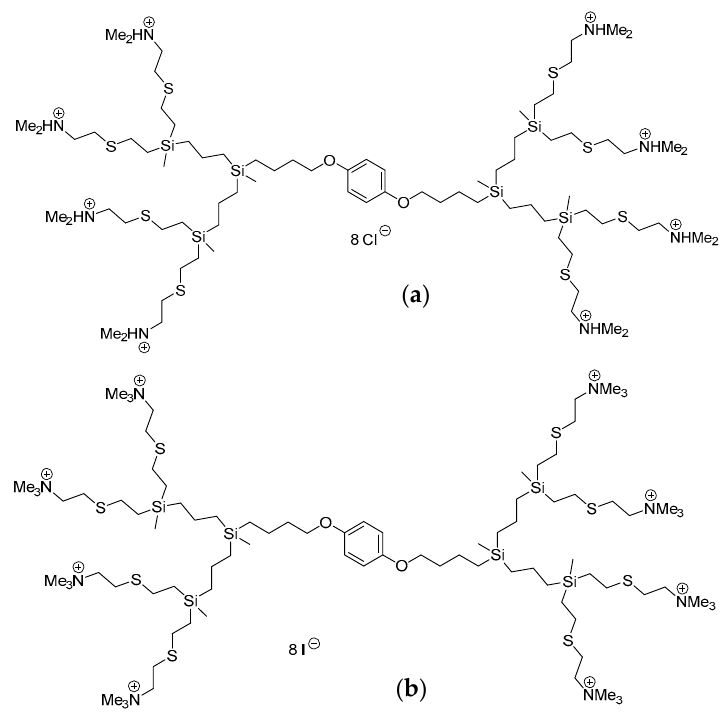
Figure 10. Molecular structure of carbosilane dendrimers: CBD-1 ( a ) and CBD-2 ( b ).